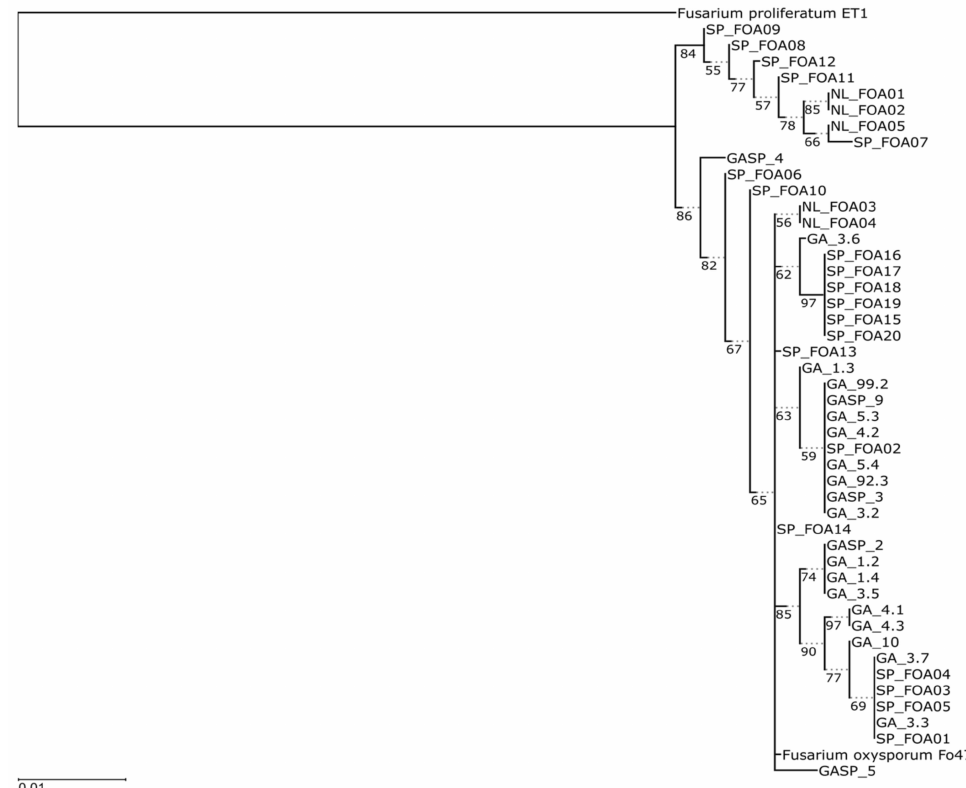
Figure 1. Consensus tree based on the maximum-likelihood analysis of the partitioned alignment of amplicons (partitions: RPB1/TNe+I/915 bp, RPB2/TNe+I/853 bp, TEF1A intron #1/K2P+R2/184 bp, TEF1A intron #2/K2P/55 bp; 22 parsimony informative sites across all partitions). Branches with less than 50% support were collapsed. Solid lines drawn to scale (units of change), dotted lines represent